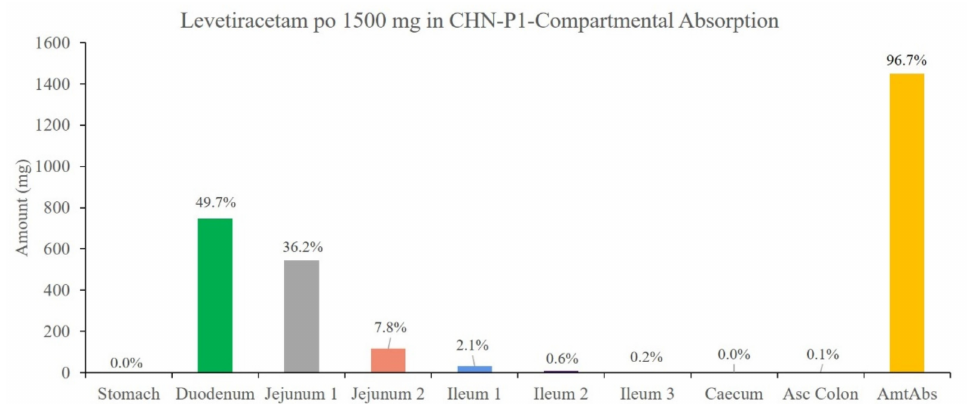
Figure 5. Percentage absorption of each intestinal segment of 1500 mg LEV orally in Chinese adults.